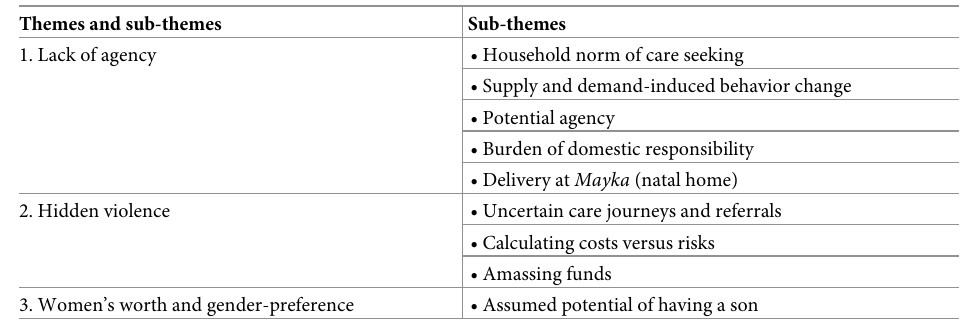
Table 2. Themes and sub-themes from qualitative